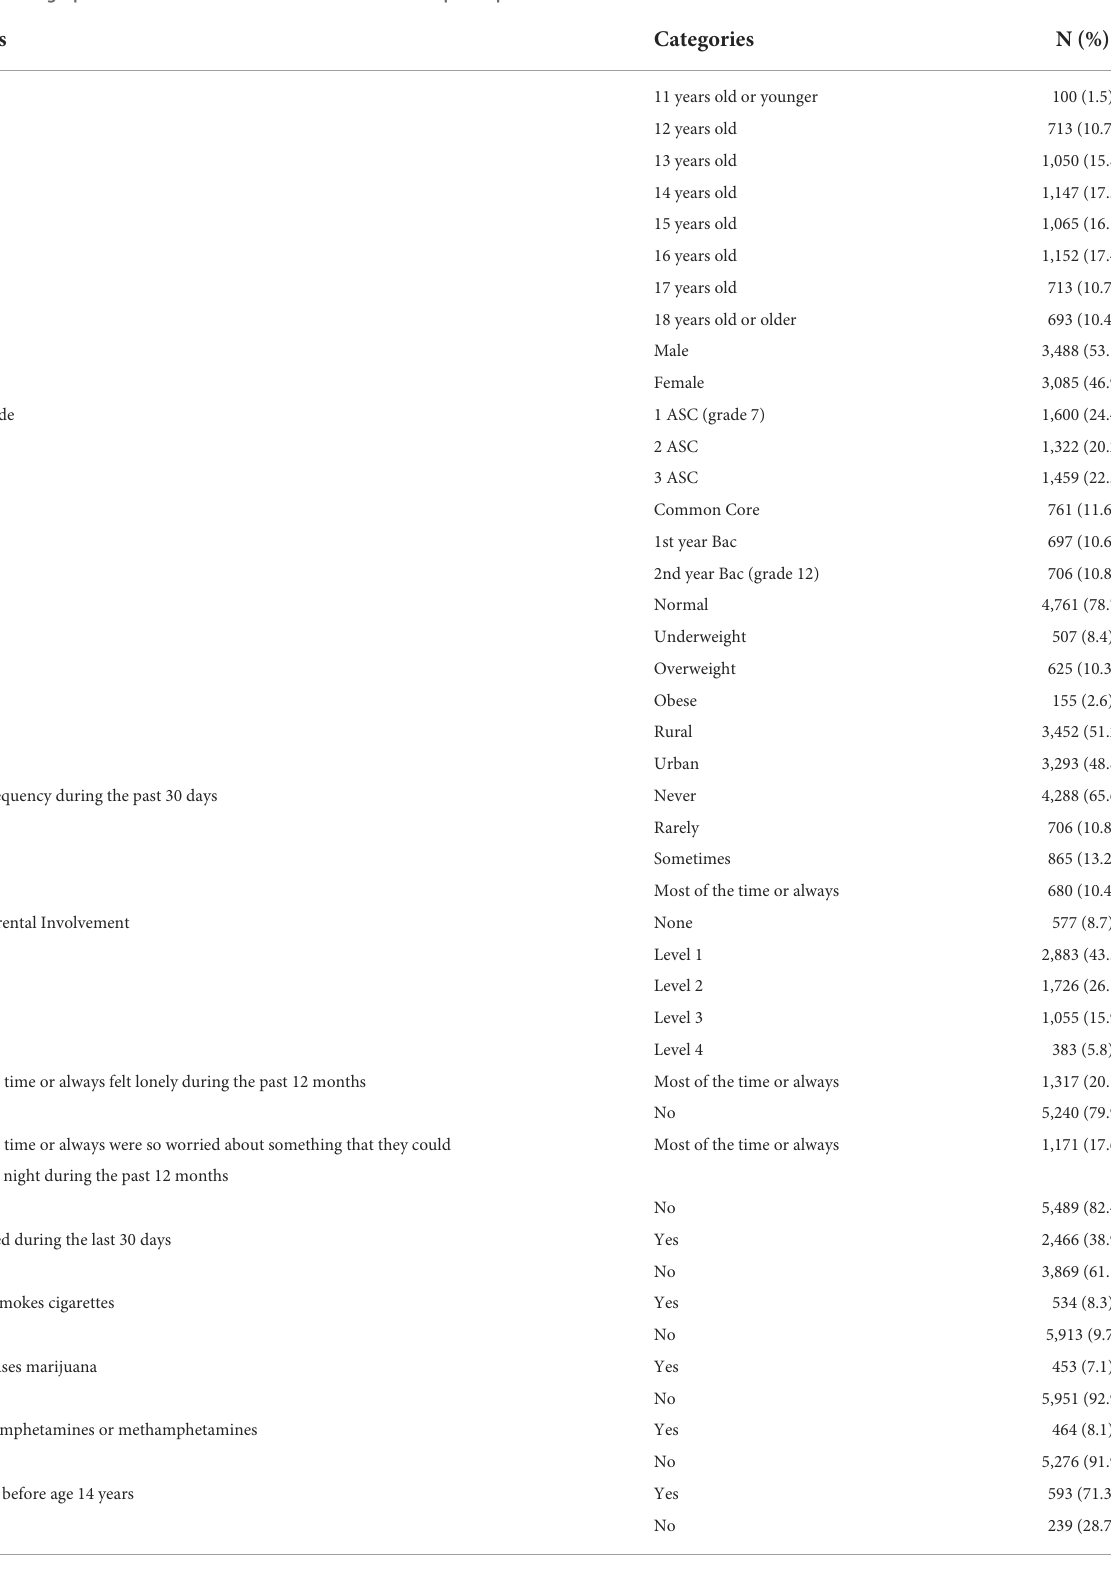
TABLE 2 Demographics and characteristics of the students that participated in the GSHS Morocco